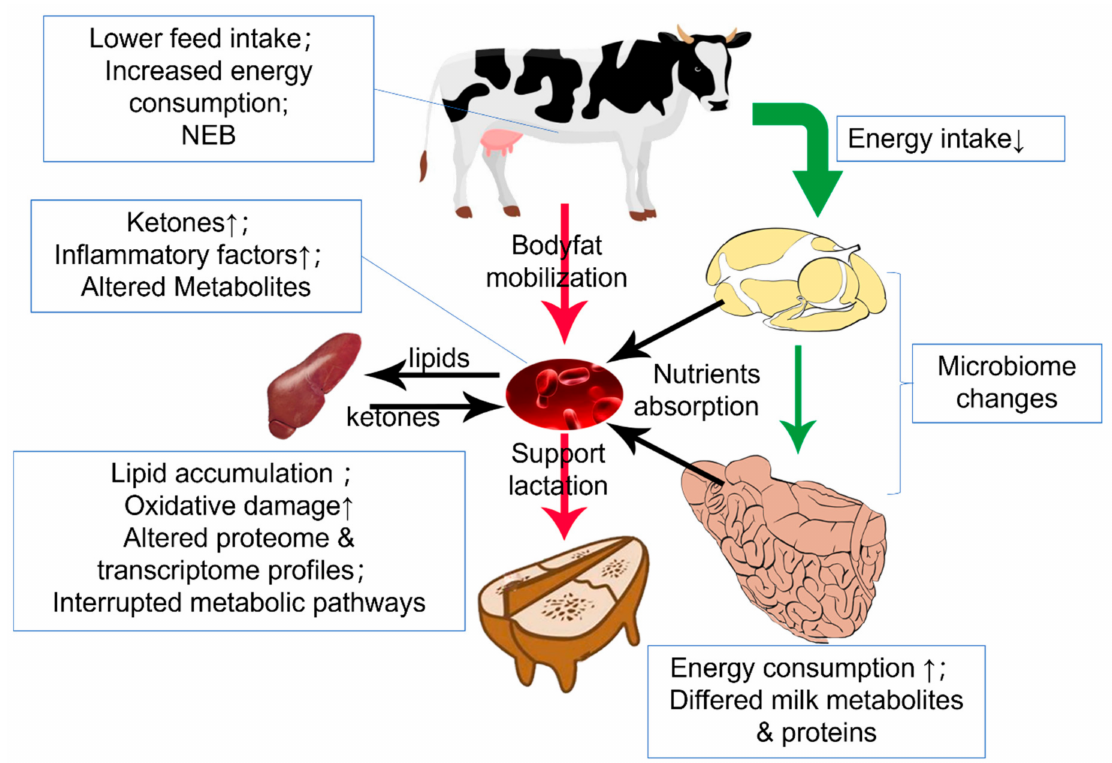
Figure 2. Metabolic condition during the transition period. Down arrow( ↓ ) means decrease and up arrow( ↑ ) means increase. In the transition period, matter intake decreases while the initialed lactation demands more energy. Hence, body fat is mobilized and oxidated into ketone in the liver. The metabolic burden of liver induces oxidative stress and